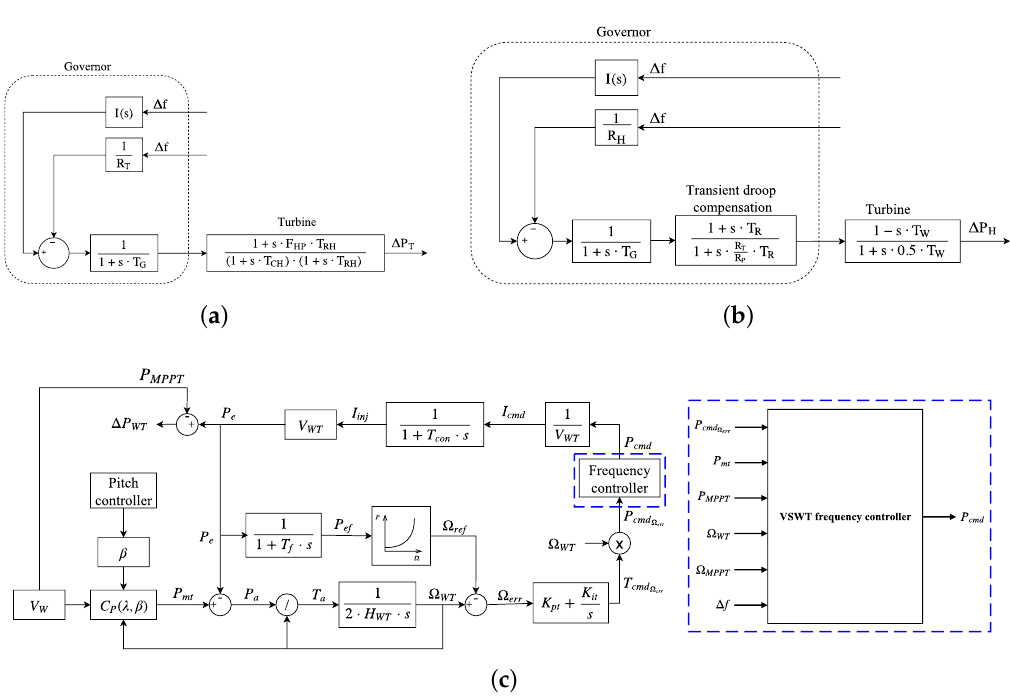
Figure 10. Power plants models. ( a ) Block diagram of a thermal plant model; ( b ) Block diagram of a